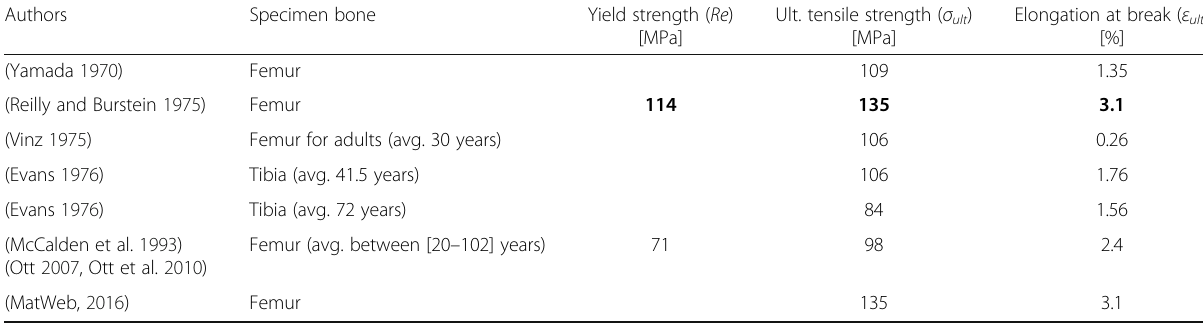
Table 1 Strength properties (average values) of the cortical bone from the